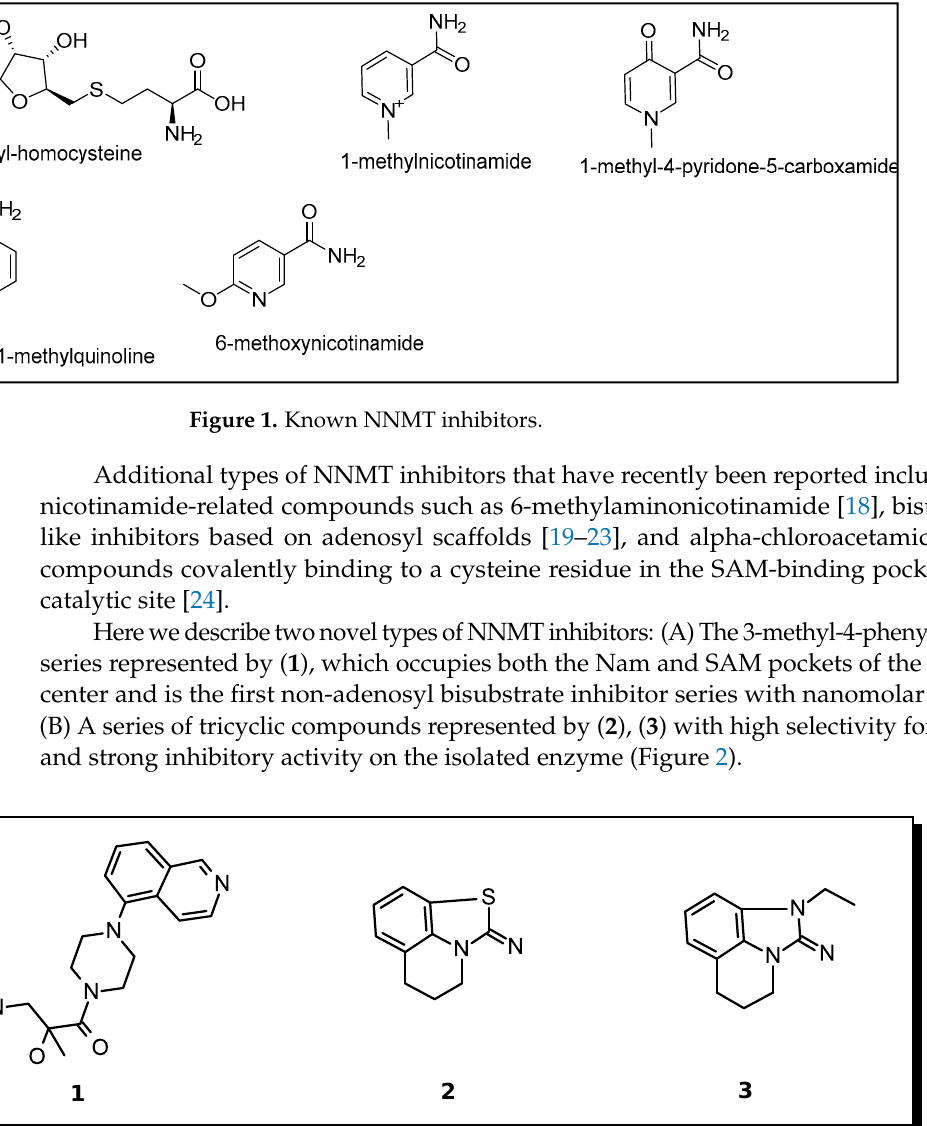
Figure 2. HTS hits identified from Sanofi compound collection.